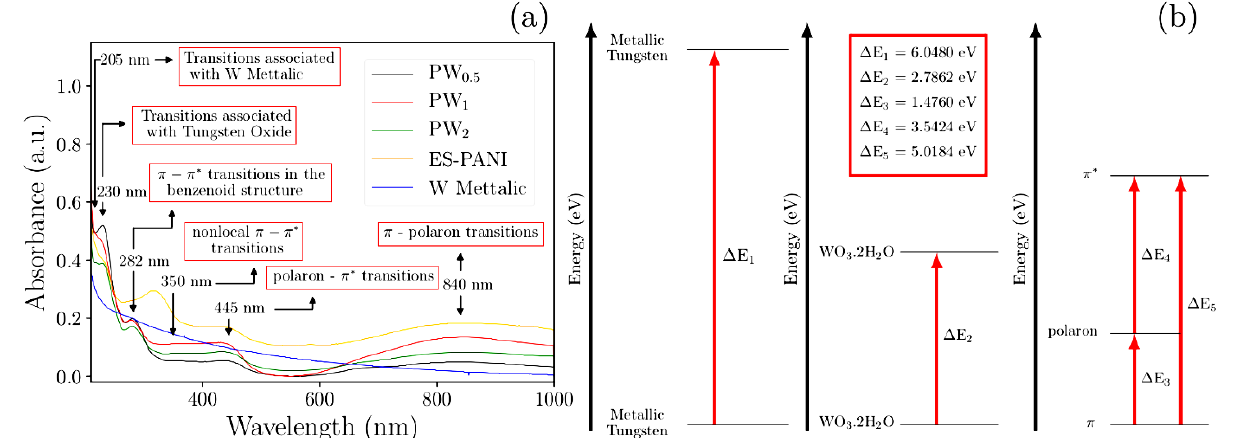
Figure 6. ( a ) UV-VIS spectra of the as -synthesized nanocomposites PW 0.5 , PW 1 and PW 2